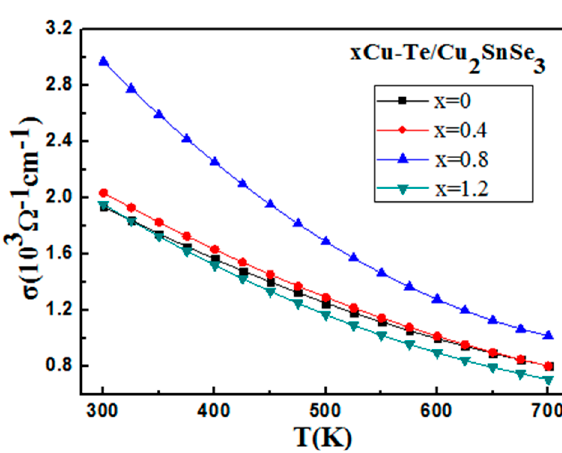
Figure 6. Temperature dependence of the electrical conductivity ( σ ) of Cu–Te/Cu 2 SnSe 3 composites.